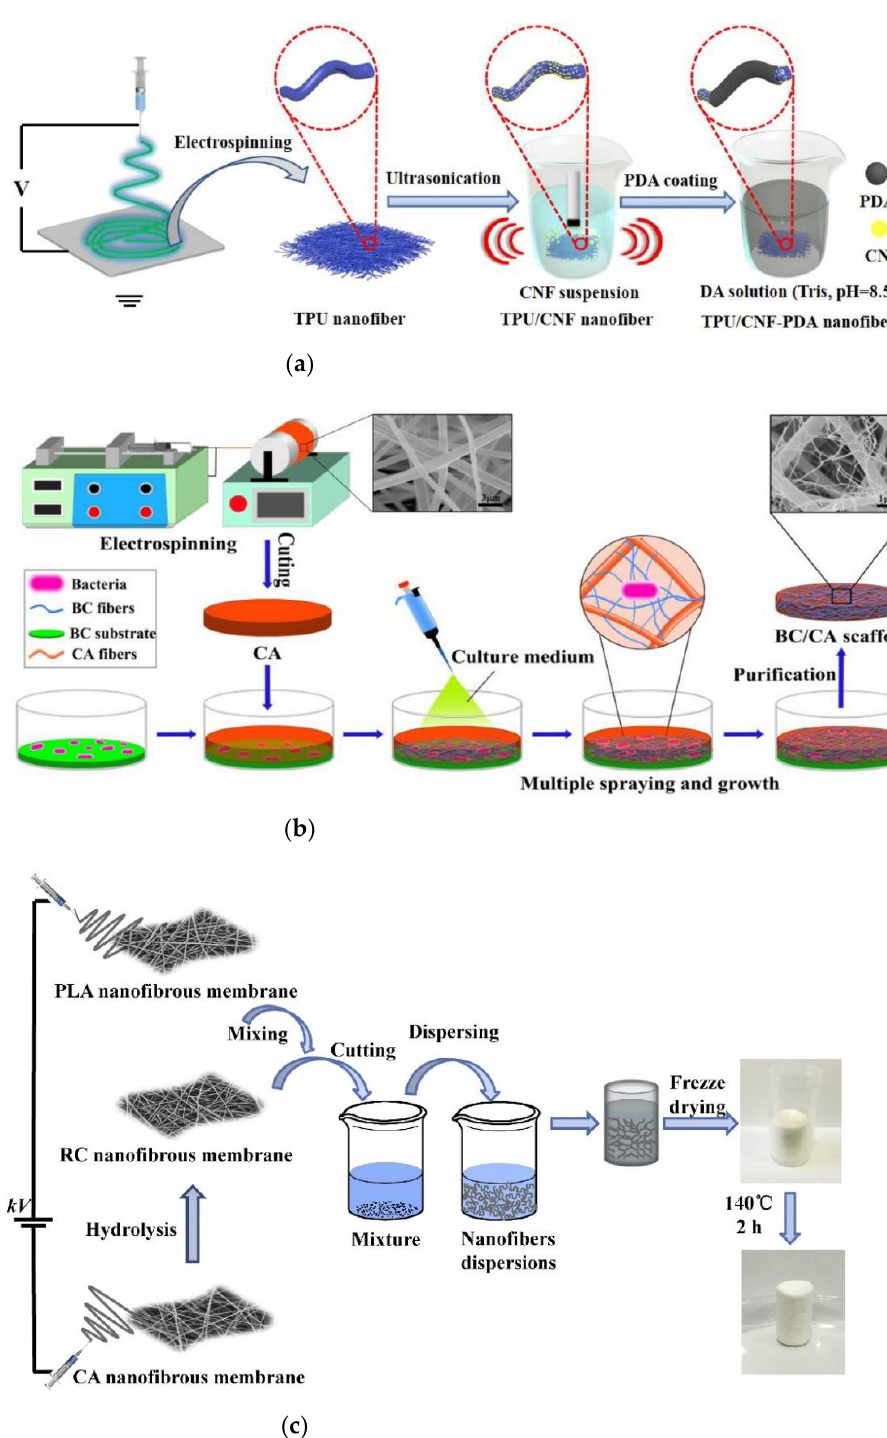
Figure 2. Schematic diagram of preparation of ( a ) TPU/CNF-PDA nanocomposite nanofibers (reproduced from [66] with permission of Taylor & Francis, 2019), ( b ) nano-submicron BC/CA scaffold, CA sub-microfibrous scaffold was fabricated by electrospinning and BC nanofibrous scaffold by in situ biosynthesis. BC/CA scaffold was prepared by spraying culture medium into the CA scaffold located on top of the BC base film, followed by multi-step in situ biosynthesis inside the CA scaffold (reproduced from [67] with permission of Elsevier, 2019), and ( c ) PLA/RC scaffold fabrication (reproduced from [68] with permission of Elsevier, 2019).